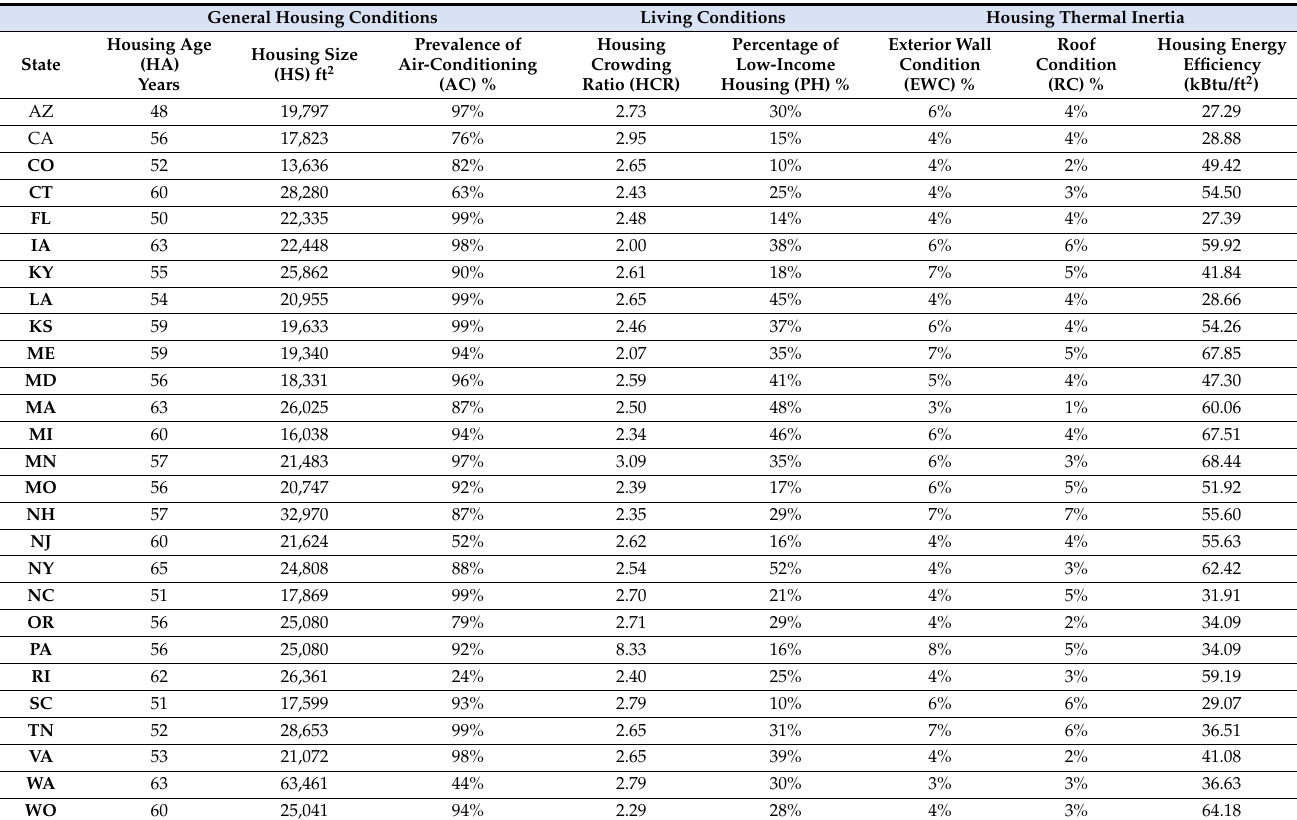
Table 3. Housing characteristic variables per